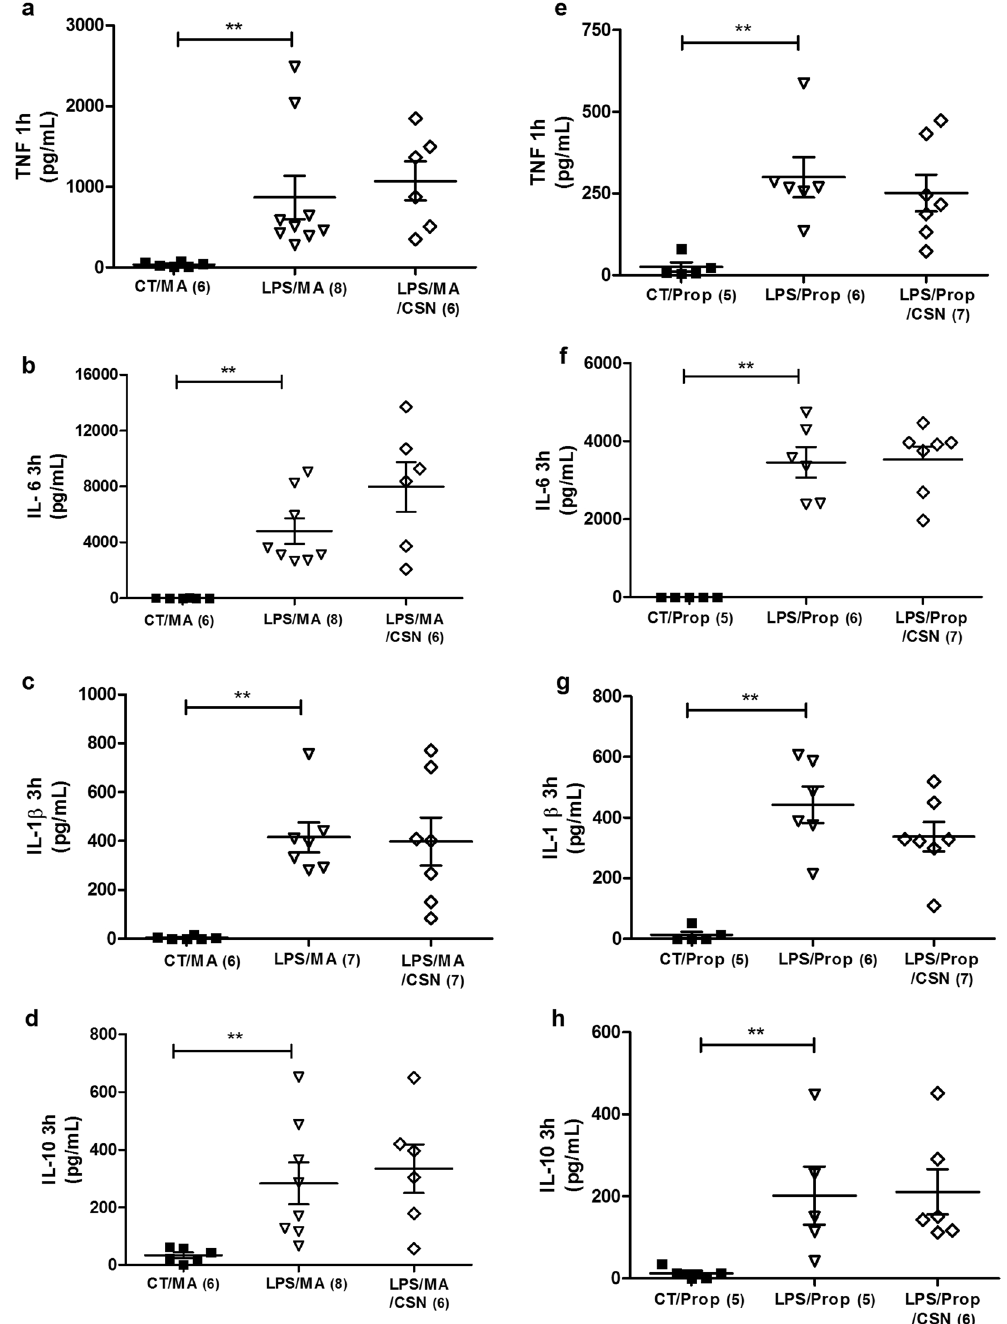
Figure 4. Methylatropine (MA) and Propranolol (Prop) administration abrogates the anti-inflammatory effect of electrical stimulation of the carotid sinus nerve (CSN) on plasma cytokines concentration in LPS induced systemic inflammation in conscious rats. Panel a : TNF ( ** p = 0.02 vs Control ) 1 hour after LPS and MA administration. Panels b , c , and d , respectively: IL-6 ( ** p = 0.007 vs Control ), IL-1 β ( ** p = 0.002 vs Control ) and IL-10 ( ** p = 0.01 vs Control ) at 3 hours after LPS and MA administration. Panel e : TNF( ** p = 0.009 vs Control ) 1 hour after LPS and Prop administration. Panels f , g , and h, respectively : IL-6 ( ** p < 0.001 vs Control ), IL-1 β ( ** p < 0.001 vs Control ), and IL-10 ( ** p = 0.04 vs Control ) at 3 hours after LPS and Prop administration. Number of animals is shown between